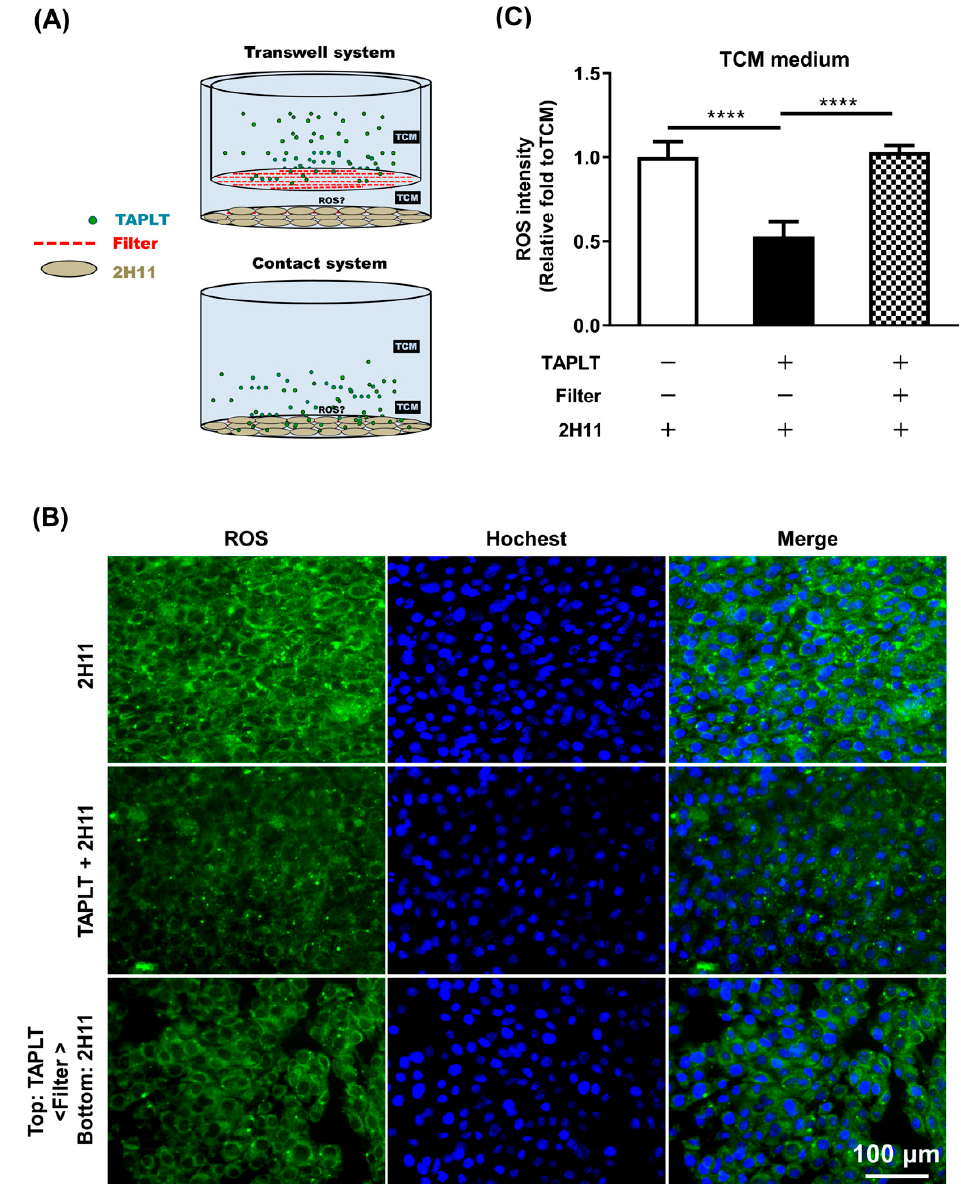
Figure 5. TAPLT directly interact with endothelial cells to render protection. ( A ) The Transwell system (top panel; pore size = 0.4 μ m) and the contact system (bottom panel) were used to test indirect and direct TAPLT-2H11 EC interactions respectively. ( B ) Visualization of the cell co-culture by fluorescence microscopy at 200× magnification. Images are representative of at least three individual experiments. ( C ) The fluorescent intensity of ROS signals was quantified from three random fields for each sample. Data represent at least three individual experiments. Mean ± SEM; ****: p < 0.0001 by two-group comparisons (t-test) as indicated.